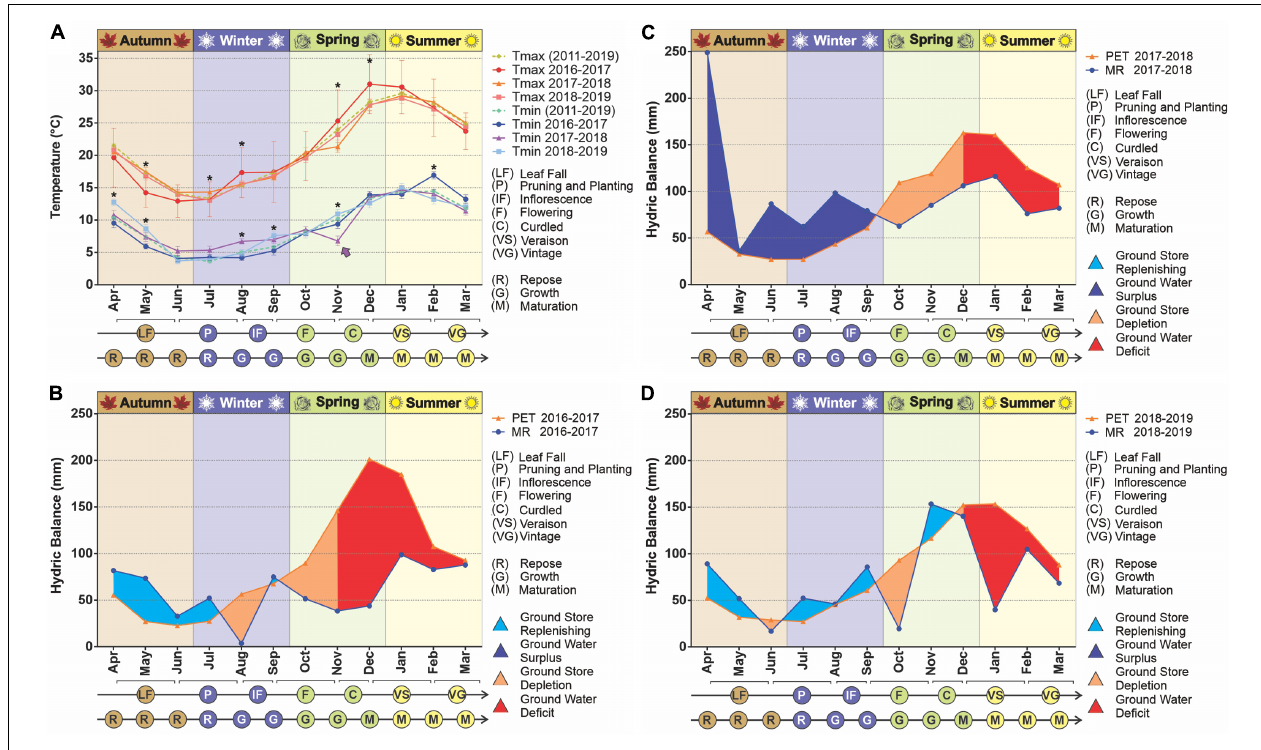
FIGURE 1 | Climatic conditions in the years 2017–2019. The temperature variation was evaluated over time (A) . Statistical analyses were performed only for the three vegetative years under study; significant differences among years, for any given month, are indicated with an asterisk ( p < 0.05). The decadic averages for minimum and maximum temperatures are added as a reference. The arrow indicates a frost, an unusual weather event for the season. The hydrologic balances were built for the years 2016–2017 (B) , 2017–2018 (C) , 2018–2019 (D) . The evaluated parameters were potential evapotranspiration (PET) and monthly rainfall